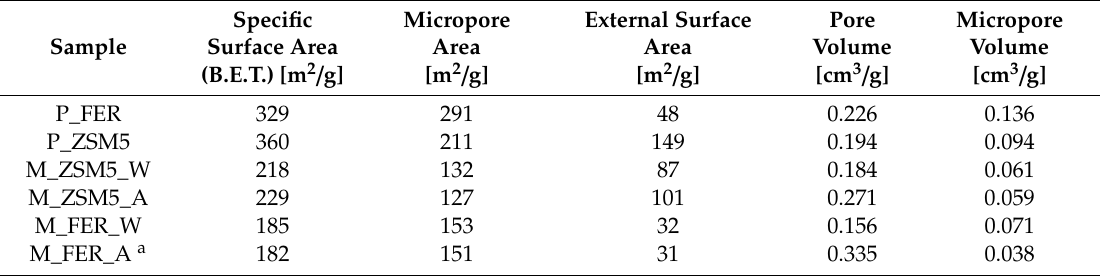
Table 1. Textural properties of parent and hybrid samples.